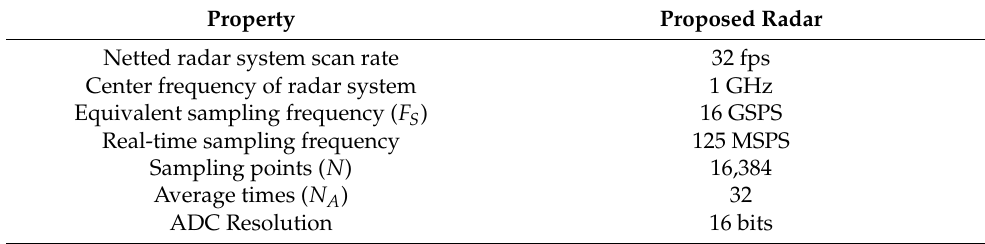
Table 1. Key parameters of the proposed radar system. ADC: analog to digital converter.